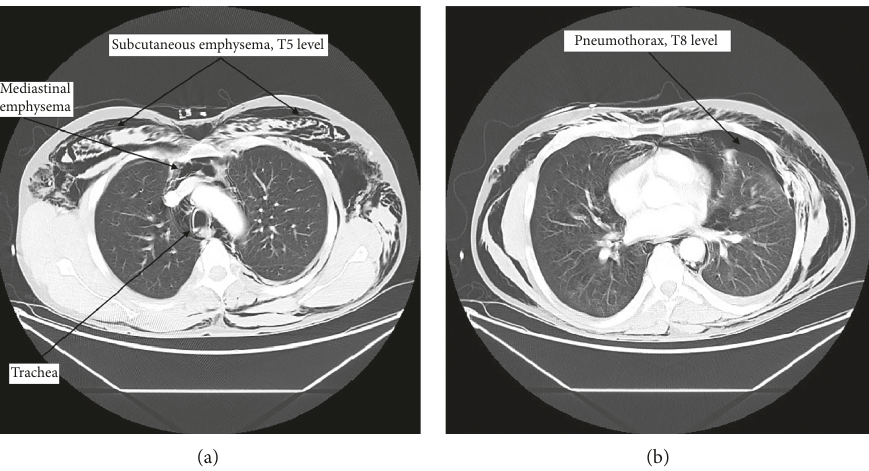
Figure 2: (a) Axial CTimage at the T5 level demonstrating extensive subcutaneous and mediastinal emphysema. (b) Axial CTimage at the T8 level demonstrating a pneumothorax on the left side. Extensive bilateral subcutaneous air is also visible.